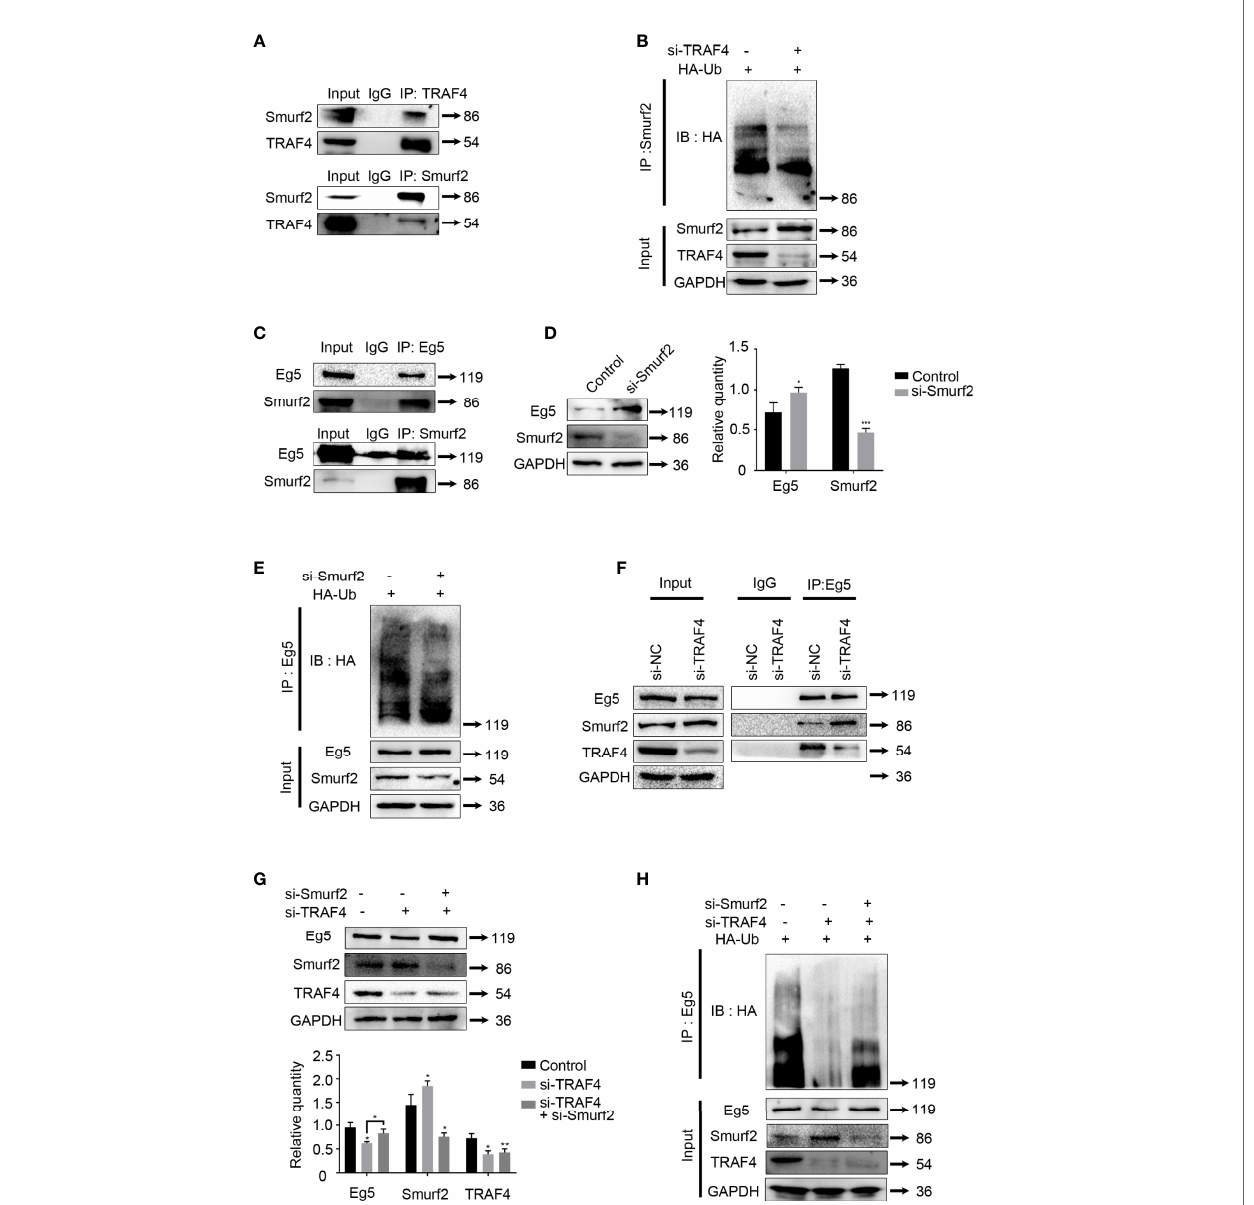
FIGURE 5 | Smurf2 mediates TRAF4 inhibition of Eg5 ubiquitination. (A) TRAF4 interacts with Smurf2. Co- immunoprecipitation assays were performed on MCF-7 cells lysates using antibodies against TRAF4 or Smurf2, followed by western blot analysis. (B) TRAF4 promoted the ubiquitination of Smurf2. MCF-7cells were co-transfected with HA-ubiquitin and TRF4 si-RNA. Co-immunoprecipitation was carried out to detected the ubiquitination levels of Smurf2, followed by western blot analysis using an antibody against HA. (C) Smurf2 interacted with Eg5. Co- immunoprecipitation assays were performed on MCF-7 cells lysates using antibodies against Eg5 or Smurf2, followed by western blot analysis. (D) Smurf2 inhibited the protein level of Eg5. The protein levels of Smurf2, Eg5 and GAPDH in MCF-7cells transfected with Smurf2 si-RNA were evaluated by western blot analysis. Data represent mean ± SD ( n = 3). (* p < 0.05, ***p<0.001). (E) Smurf2 promoted the ubiquitination of Eg5. MCF-7cells were co-transfected with HA-ubiquitin and Smurf2 si-RNA. Co-immunoprecipitation was carried out to detected the ubiquitination levels of Eg5, followed by western blot analysis using an antibody against HA. (F) TRAF4 inhibits the interaction between Smurf2 and Eg5. MCF-7 cells were transfected with or TRAF4si-RNA. Co- immunoprecipitation assays were performed using antibodies against Eg5, followed by western blot analysis. (G) TRAF4 regulated the protein level of Eg5 through Smurf2. MCF-7 cells were transfected with control si-RNA or Traf4 si- RNA with or without Smurf2 si-RNA. The protein levels of Smurf2, Eg5 and GAPDH were analyzed by western blot analysis. Data represent mean ± SD ( n = 3). (* p < 0.05, **p<0.01). (H) Smurf2 mediates TRAF4 inhibition of the ubiquitination of Eg5. MCF-7 cells were co-transfected with HA-ubiquitin vector and TRAF4 si-RNA with or without Smurf2 si-RNA. Eg5 ubiquitination levels were detected following co-immunoprecipitation using antibodies against Eg5 by western blot analysis using an antibody against